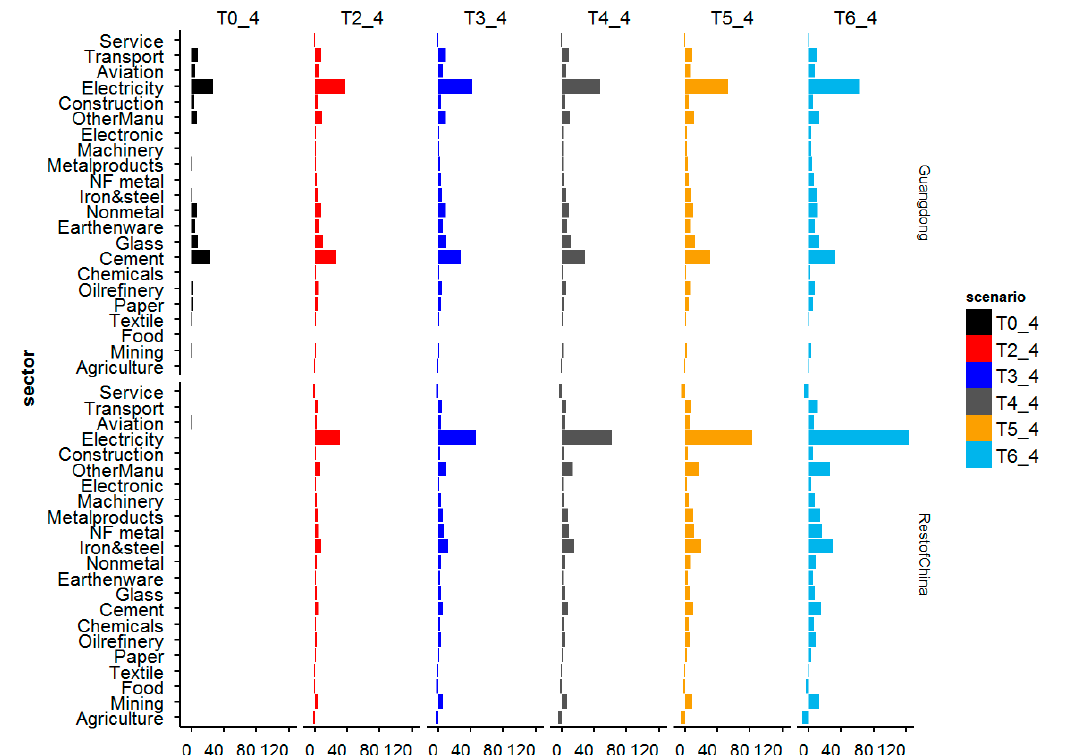
Figure 3. Provincial production price change from BaU (%) in 2030.